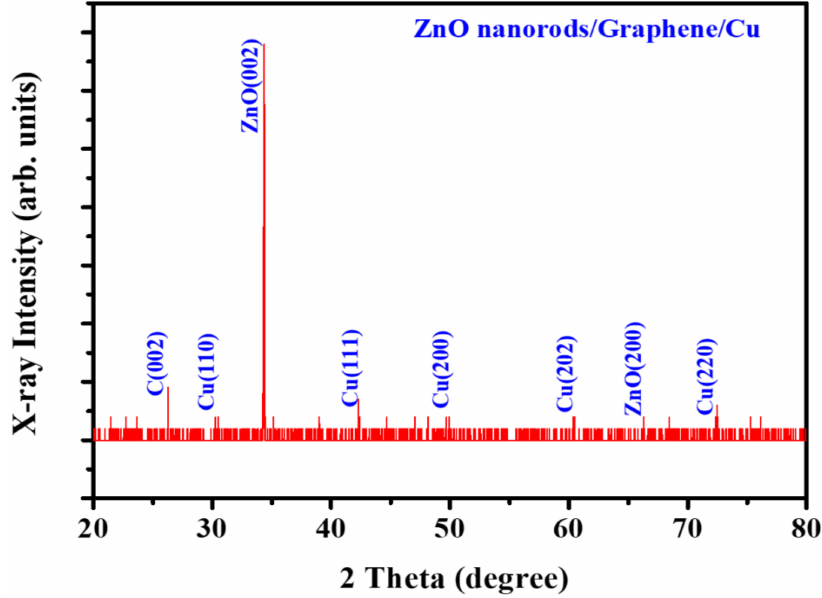
Figure 4. XRD (X-ray Diffraction) pattern of the ZnO NRs grown on Zn pre-deposited graphene/Cu sheet from the sample shown in Figure